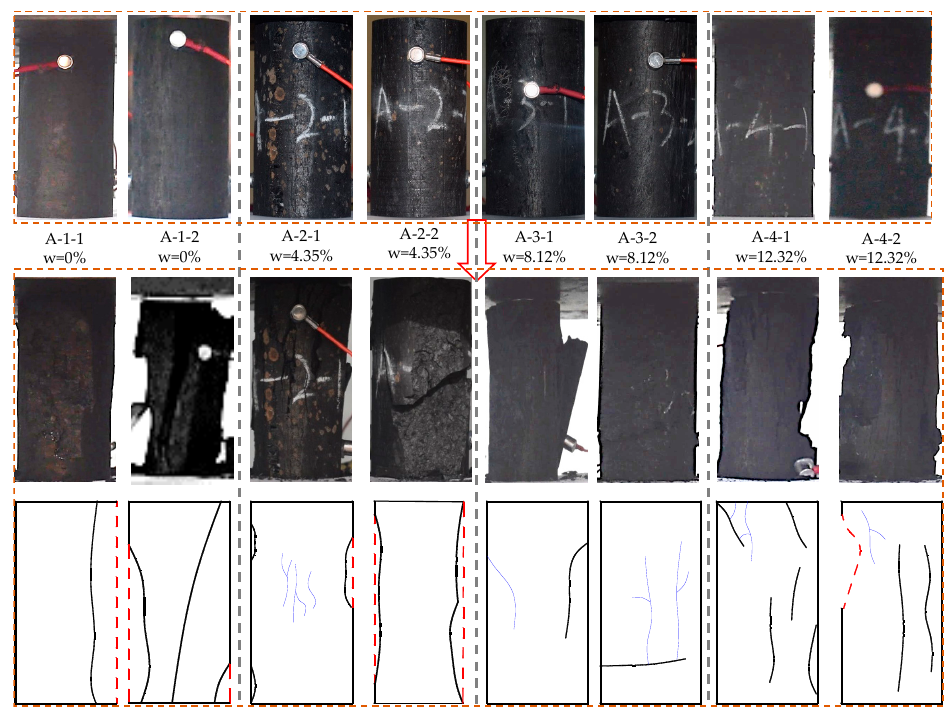
Figure 9. Loading failure diagram for coal samples at various moisture contents. Figure 10 is a diagrammatic sketch of failure cracks of coal samples with different drying and watering circles. There is an accumulation of small-formed tension cracks, as the frequency of drying–wetting circles increases, and most of them are in the form of penetration. In addition, the shear crack decreases, the tension crack is progressively added, and the damage pattern of coal sample shifts from shear-dominated tension–shear mixed damage to tension-dominated mixed failure.